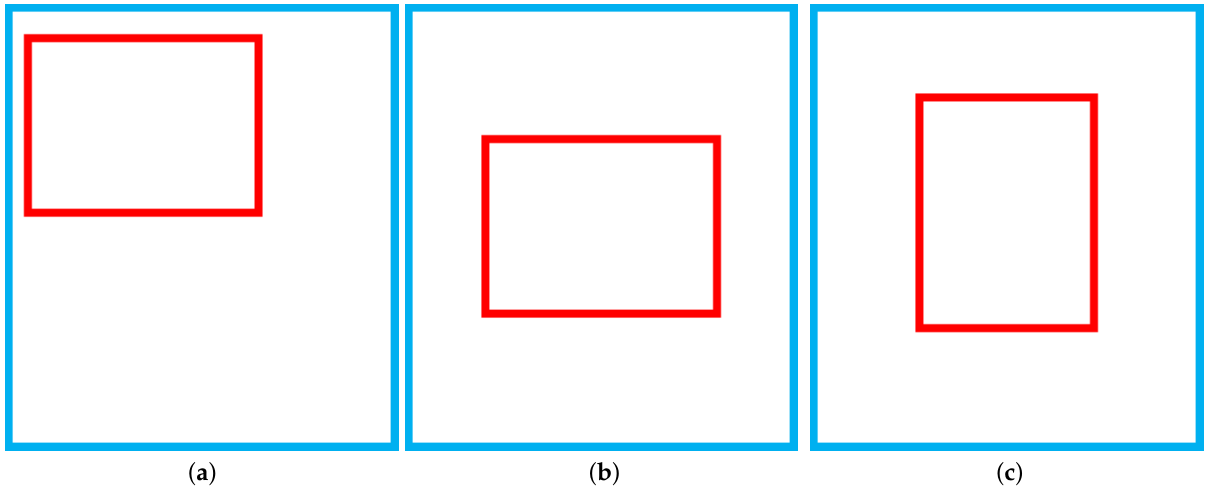
Figure 7. IoU faces the case of a box contained in another box. Blue box is B gt , and the red box is B . ( a – c ) denote the different B contained in the same B gt inner where the area of B is constant. The IoU is the same in all three cases.